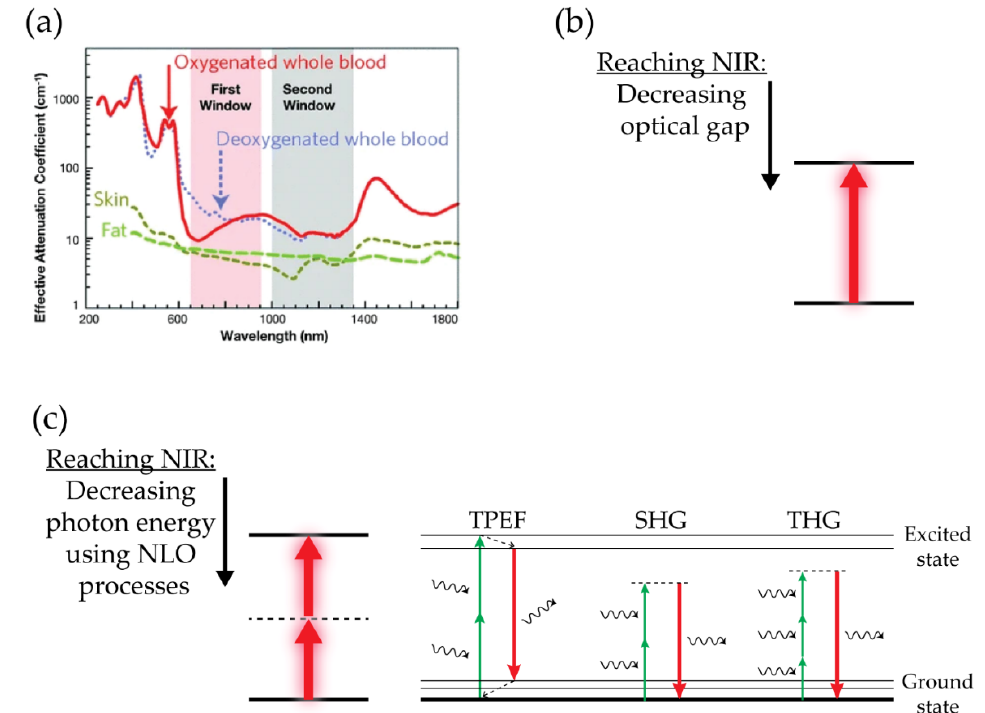
Figure 1. Optical imaging in biological samples. ( a ) Tissues such as skin, fat, and blood (oxygenated and deoxygenated) attenuate light in a wavelength-dependent manner due to absorption and scattering. Attenuation is the lowest in the first (NIR-I, 700–900 nm, shaded in pink) or second near-infrared window (NIR-II, 1000–1700 nm, shaded in grey). Image adapted from [112] with permission from Springer Nature. ( b , c ) Strategies for reaching the NIR-I and NIR-II windows: using chromophores with small optical gaps ( b ) or applying NLO techniques (SHG, THG, and TPEF) ( c ). Images adapted from